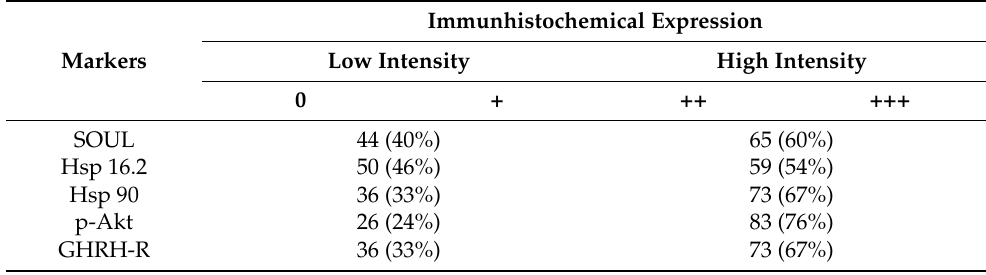
Table 2. Immunhistochemical expression of proteins in pretreatment tumor specimens. Immunhistochemical Expression Low Intensity High Intensity Markers